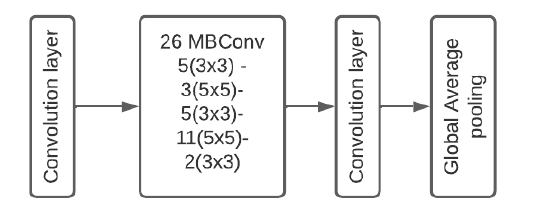
Figure 5. EfficientNetB3